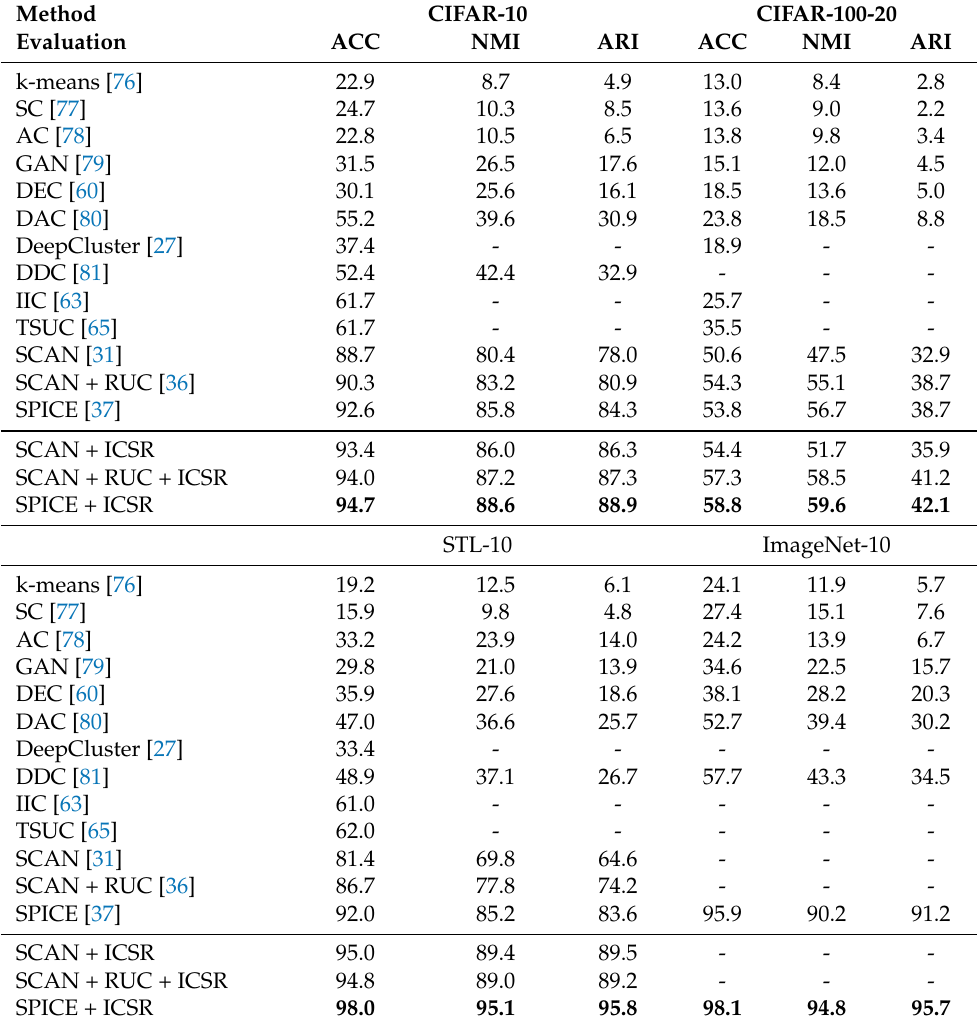
Table 2. Evaluation of image clustering performances. Building on three state-of-the-art clustering models, SCAN, RUC, and SPICE, ICSR can significantly improve these models, achieving perfor- mance gains ranging from 2.0% to 13.6%. For the case where the performance is already very high 95.9%, ICSR can still improve it further to 98.1%, very close to a perfect 100%. The best results are highlighted by the